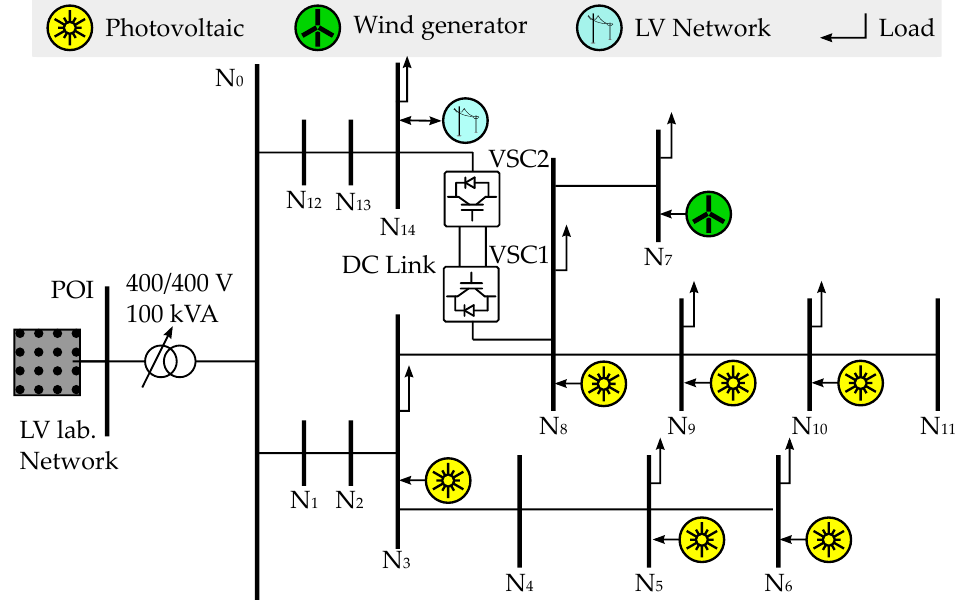
Figure 5. One-line diagram of the MV physical network within the PSHIL infrastructure at the University of Sevilla.